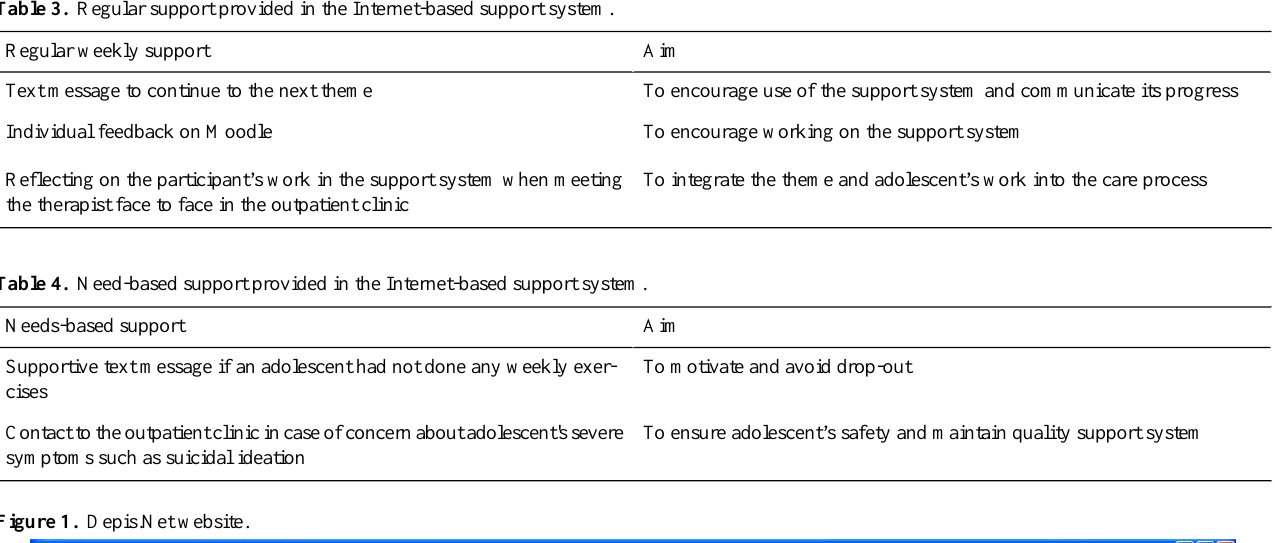
Figure 1. Depis.Net